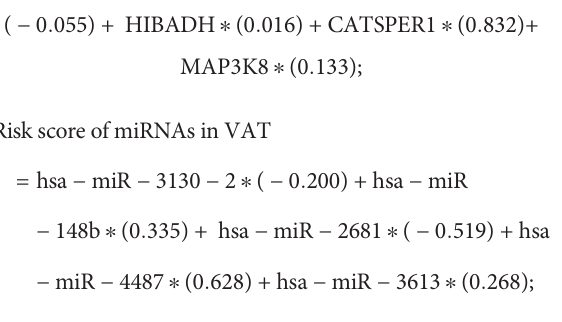
(SORCS1, FLRT3, HIBADH, CATSPER1, and MAP3K8) and 5 DE miRNAs (hsa-miR-3130-2, hsa-miR-148b, hsa-miR-2681, hsa-miR-4487, and hsa-miR-3613) of obesity-related ccRCC with statistically signi fi cant adjusted HRs remained consistent trends (up- and down-regulated) as shown in DE analyses of obesity in VAT. For DE RNAs of obesity-related ccRCC in SAT, 4 mRNAs (ENO2, YY1AP1, FAP, IL10RB) and 1 miRNA (hsa-miR- 425) were eligible for the following risk score analyses. By utilizing adjusted regression coef fi cients of these RNAs, we calculated risk scores of both mRNAs and miRNAs for each patient. Formulas